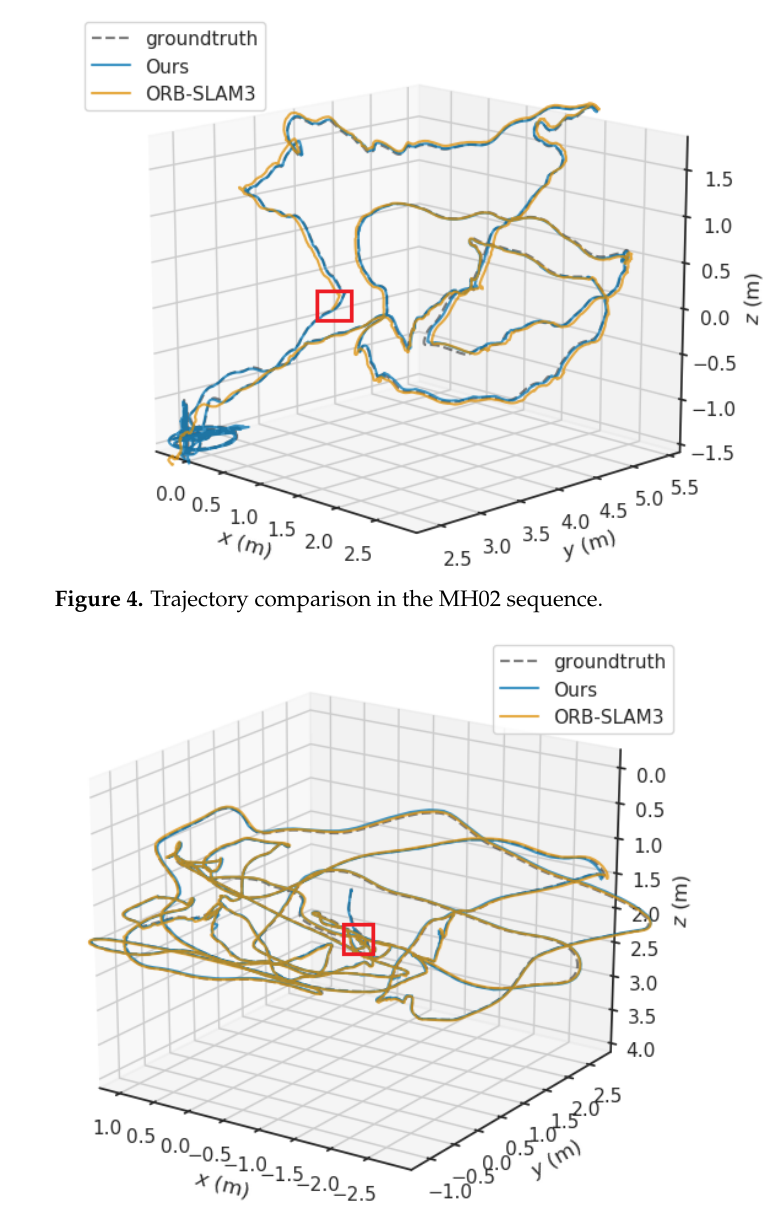
Figure 5. Trajectory comparison in the V203